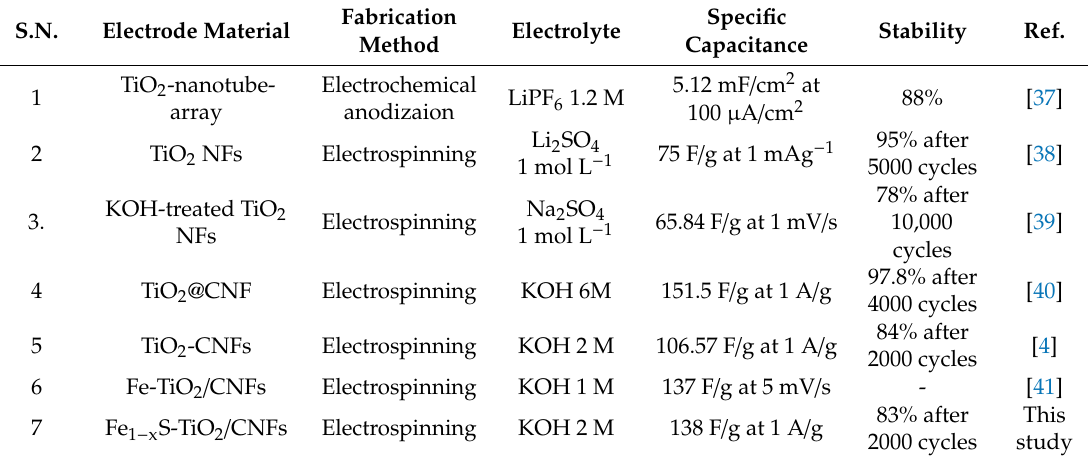
Table2. Comparisonoftheelectrochemicalperformanceofas-synthesizedFe 1 − x S-TiO 2 / CNFscomposite as a supercapacitor electrode material with some other TiO 2 -based electrodes.